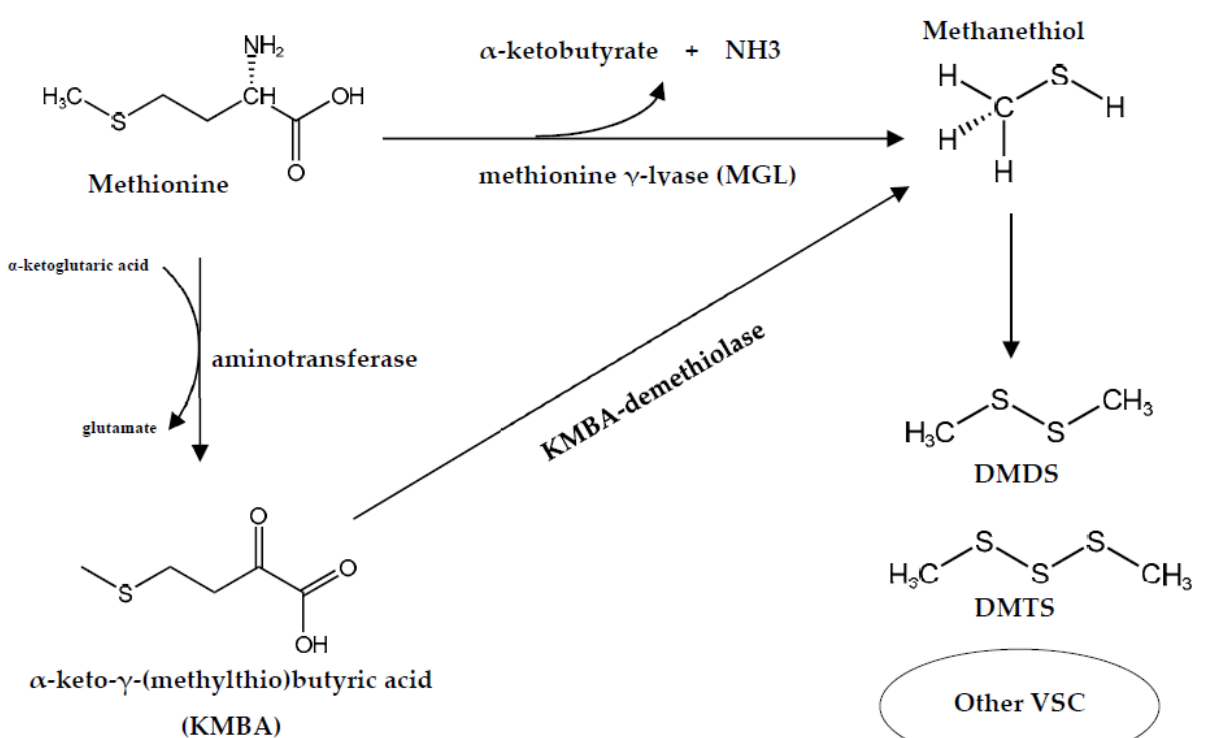
Figure 1. Methionine degradation pathways related to flavor formation in cheese by bacteria belonging to the genus Arthrobacter .